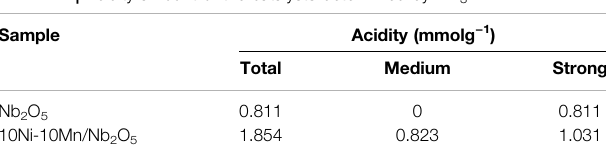
TABLE 2 | Acidity amount of the catalysts determined by NH 3 -TPD. Sample